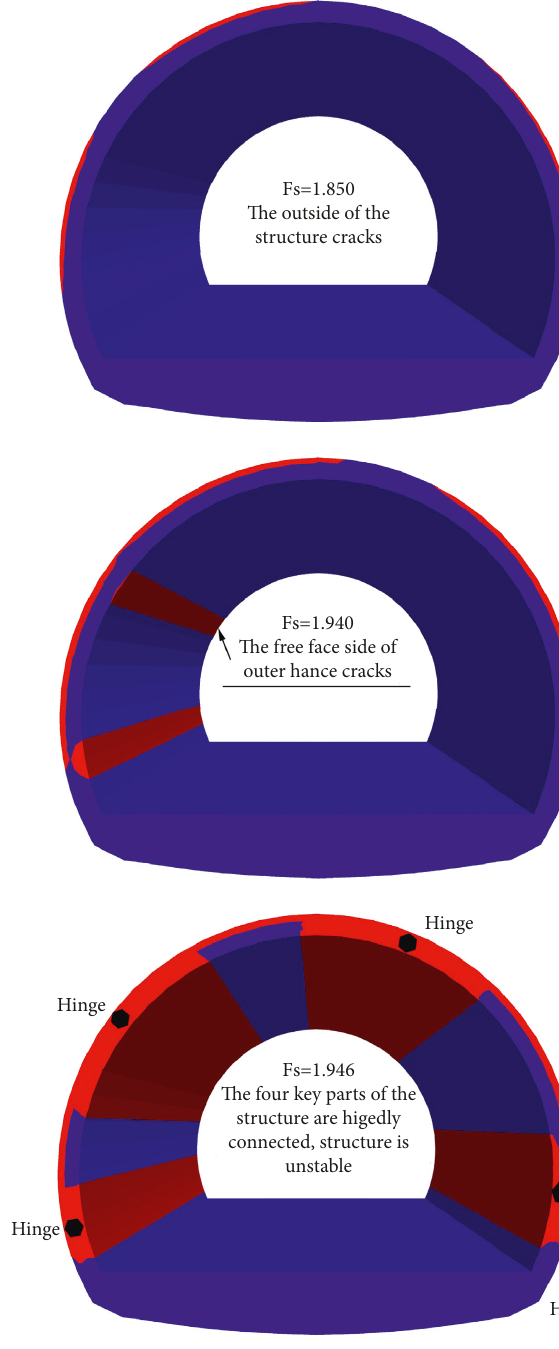
Figure 9: Ultimate strain cloud diagram of lining structure under different reduction